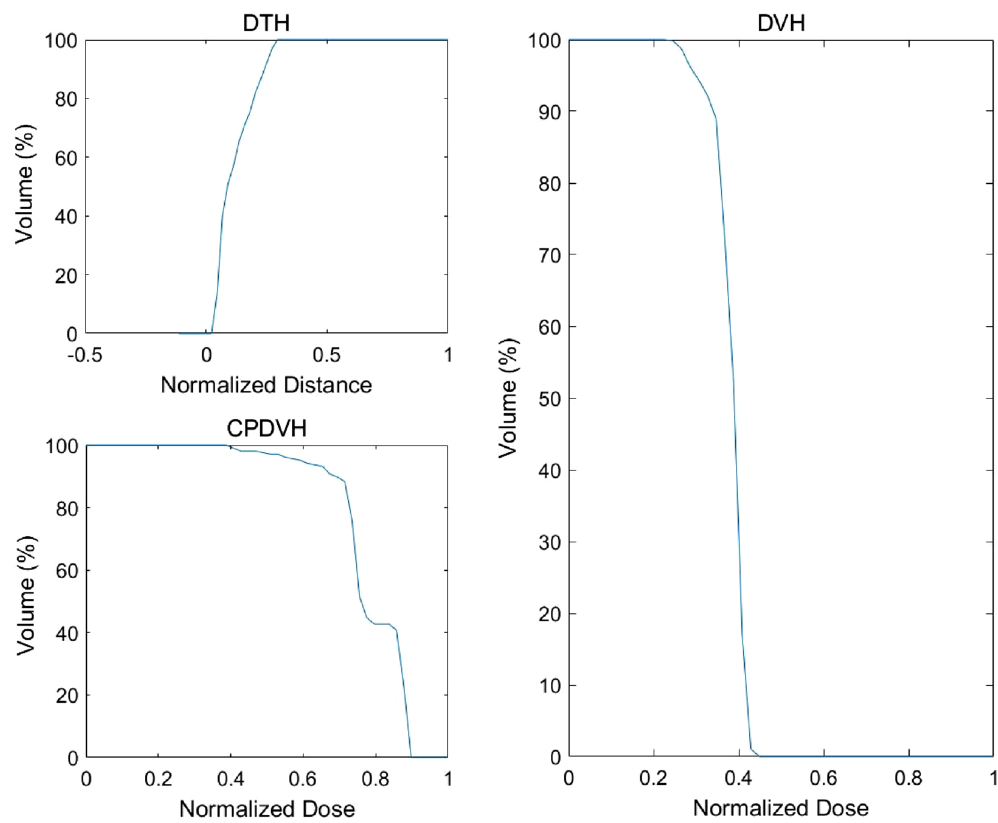
Figure 2. The DTH, CPDVH and DVH of an OAR.